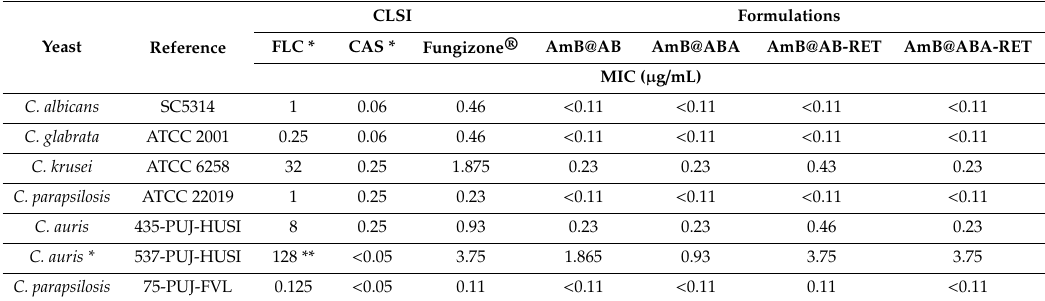
Table 7. Values of minimum inhibitory concentration (MIC) of AmB@PMs formulations compare with Fungizone ® and profiles of susceptibilities of Candida spp. to fluconazol and caspofungine by CLSI reference methodology.